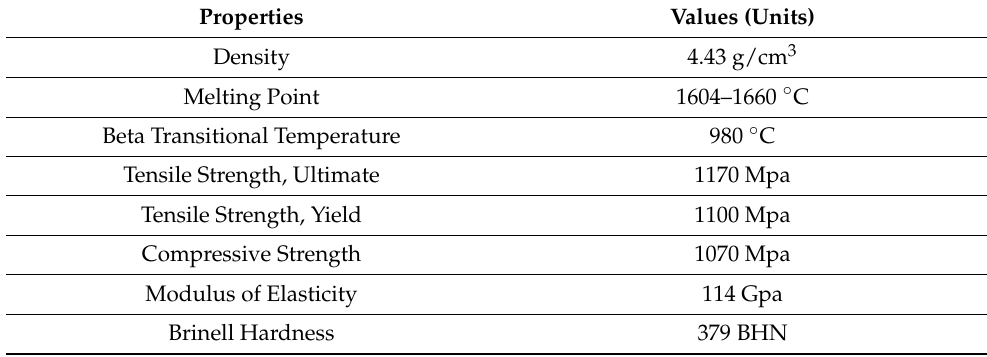
Table 3. Thermal properties and Mechanical Properties of Ti-6Al-4V alloy [20].